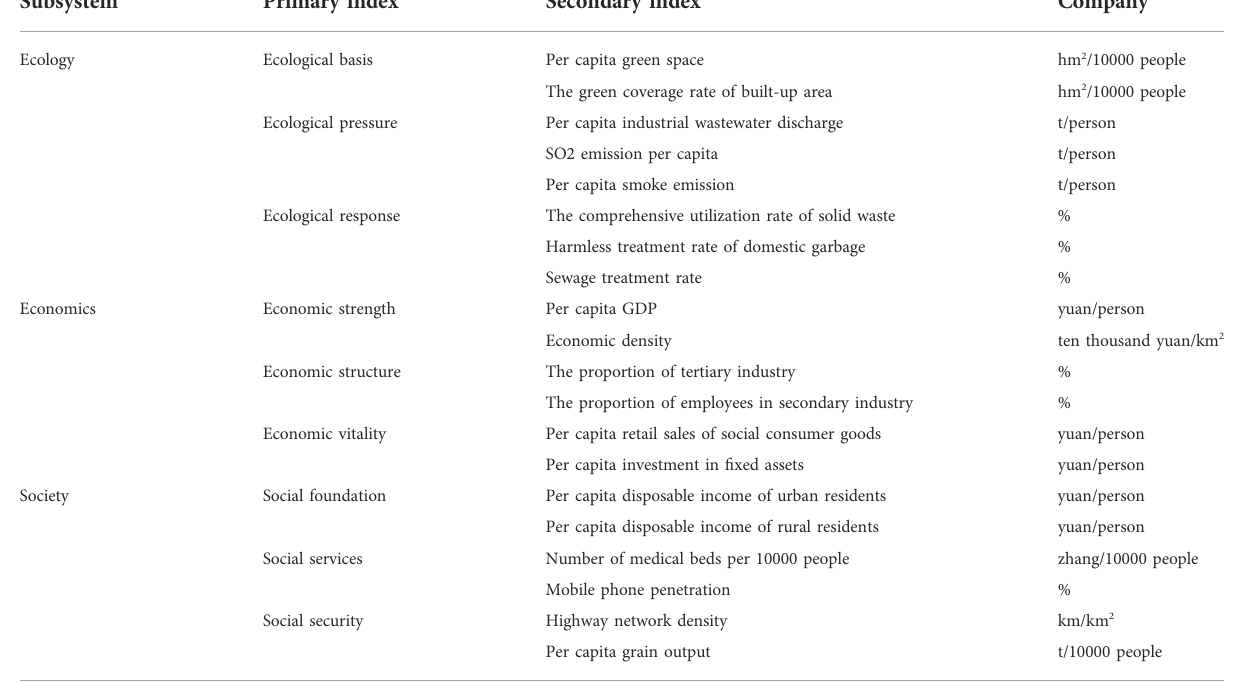
TABLE 1 Evaluation index system of ecological civilization construction (ECC)